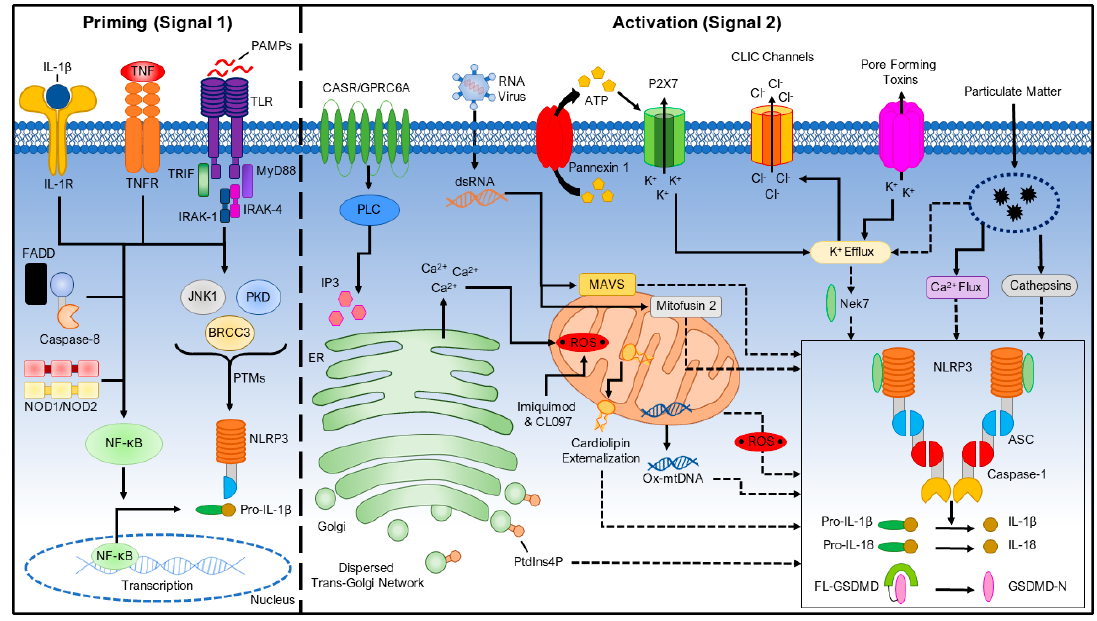
Figure 1. A Two-Signal Model for NLRP3 Inflammasome Activation. The priming signal (signal 1, left ) is provided by microbial components or endogenous cytokines, leading to the activation of the transcription factor NF- κ B and subsequent upregulation of NLRP3 and pro-interleukin-1 β (pro-IL-1 β ). Caspase-8 and FAS-mediated death domain protein (FADD), and NOD1/2 are involved in the priming step by regulating the NF- κ B pathway. NLRP3 undergoes post-translational modifications that license its activation. The activation signal (signal 2, right ) is provided by a variety of stimuli including extracellular ATP, pore-forming toxins, RNA viruses, and particulate matter. Multiple molecular or cellular events, including ionic flux, mitochondrial dysfunction and reactive oxygen species (ROS) generation, and lysosomal damage, have been shown to activate the NLRP3